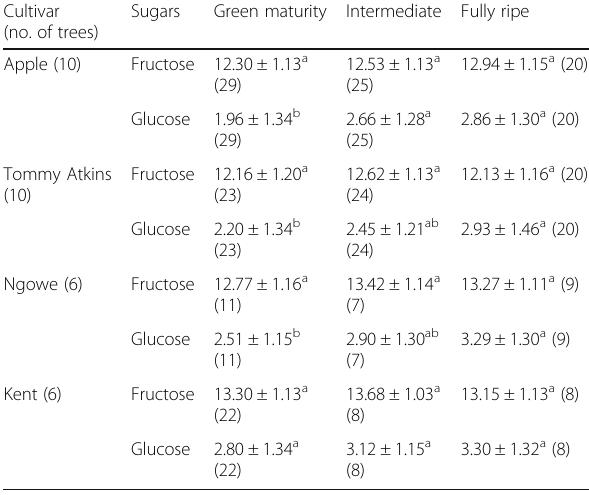
Table 4 Fructose and glucose contents of four mango cultivars at three stages of maturity in KARI-Thika site, mean ± SD ( N ) Cultivar (no. of